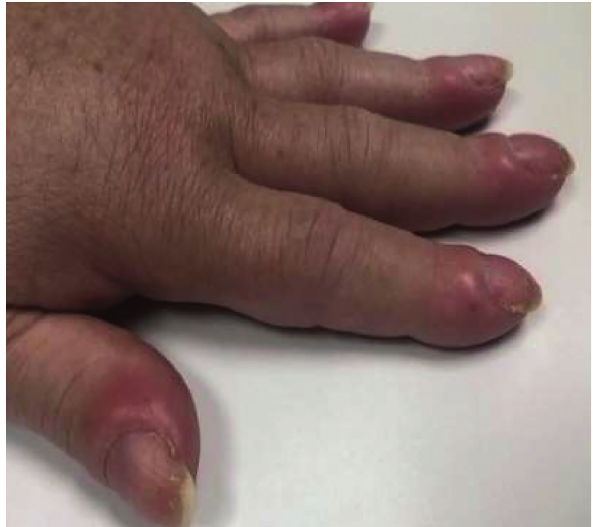
Figure 1: Clubbing of distal phalanges.